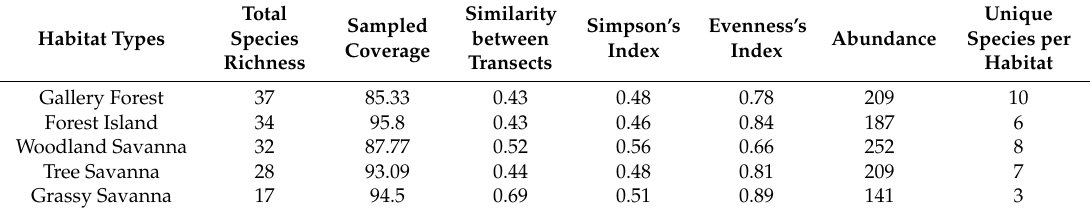
Table 2. Dissimilarity assessment of termite assemblages between the visited habitats.